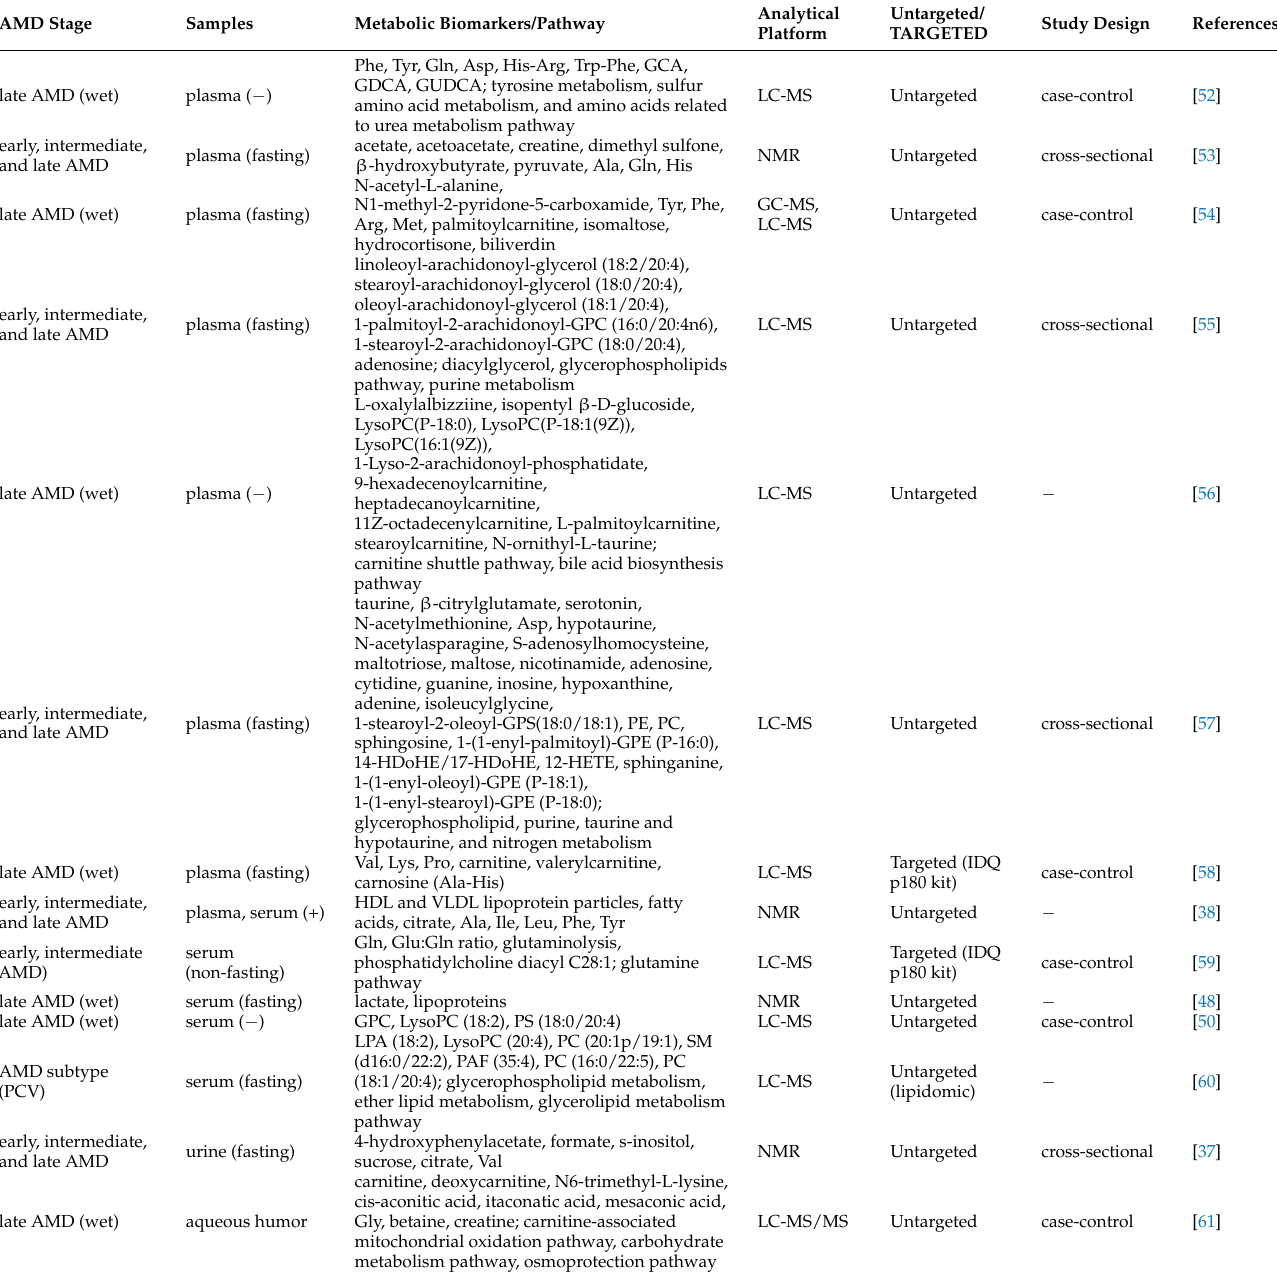
Table 1. Summary of metabolomics-based clinical studies of